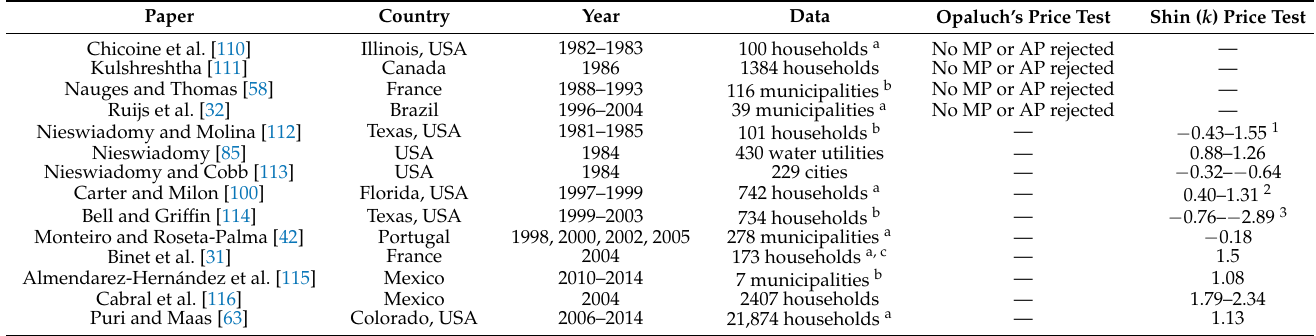
Table 1. Summary of papers testing the perceived price using Opaluch’s or Shin’s